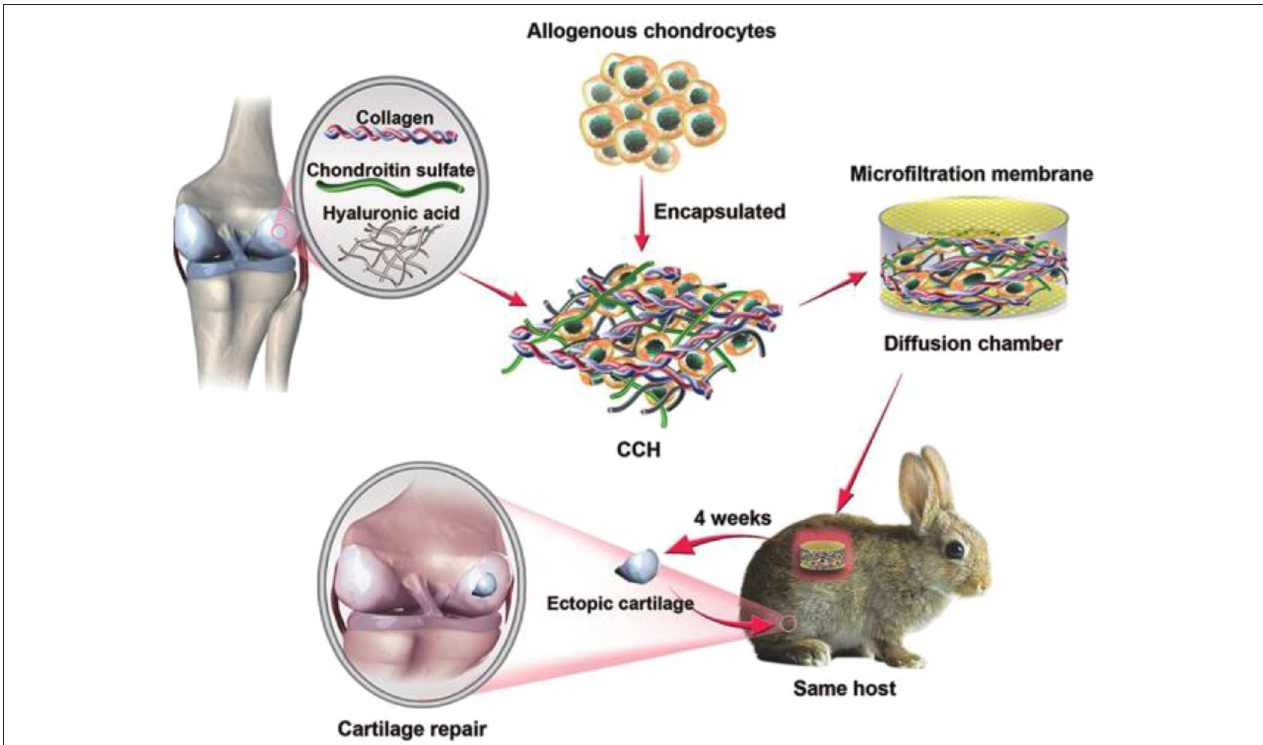
FIGURE 6 | Schematic illustration of the overall design of three-phase hybrid hydrogels. Allogeneic chondrocytes are encapsulated with a CCH hybrid hydrogel, forming the ectopic cartilage with a diffusion chamber system for cartilage repair. Reproduced from Jiang et al. (2018) with permission from Copyright 2018 Royal Society of